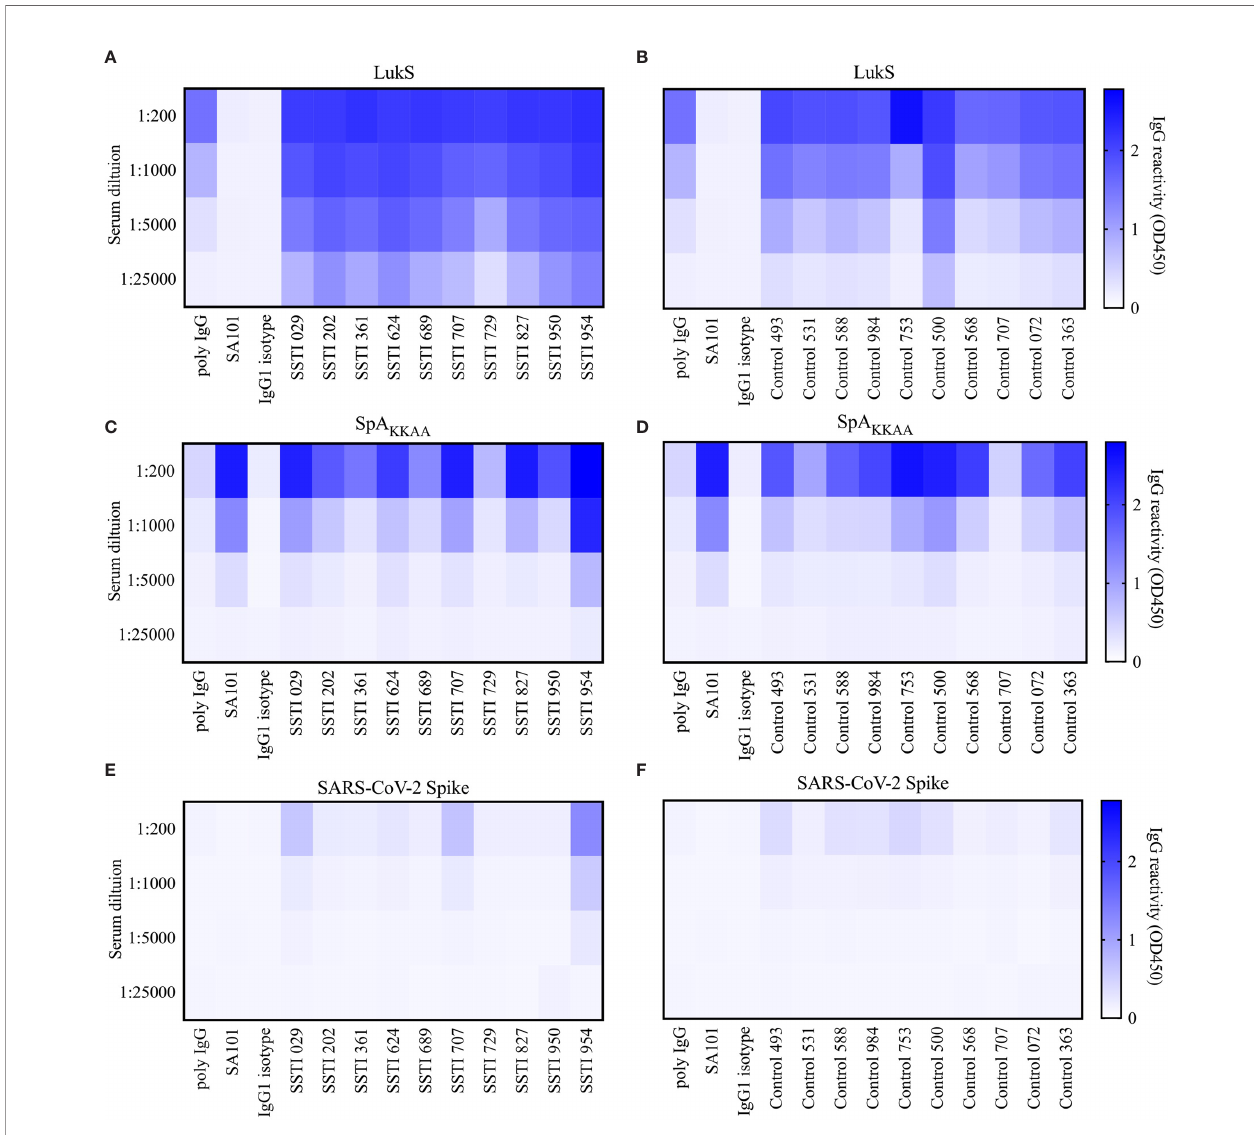
FIGURE 7 | Serum reactivity to Leukocidin S, SpA KKAA and Spike protein in patients with Skin and Soft Tissue Infections (SSTI) and controls. (A) Serum binding reactivity measured as OD 450nm to Leukocidin S (LukS) from Staphylococcus aureus by individuals with skin and soft tissue infections (SSTI) at 1:200, 1:1000, 1:5000 and 1:25,000 serum dilutions and mAb controls at 10, 2, 0.4 and 0.08 µg/mL. (B) Binding reactivity to LukS by control serum and mAb controls. (C) Binding reactivity to SpA KKAA by SSTI sera and mAb controls. (D) Binding reactivity to SpA KKAA by control serum and mAb controls. (E) Binding reactivity to Spike protein from SARS-CoV-2 by SSTI sera and mAb controls. (F) Binding reactivity to Spike protein by control serum and mAb